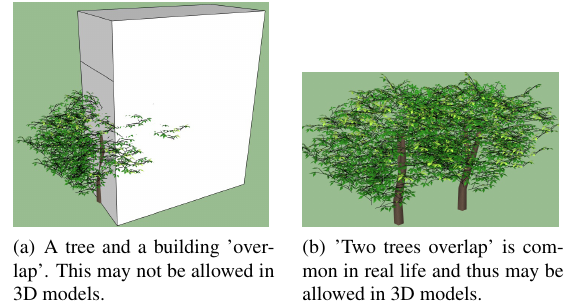
Figure 3: Objects with the same geometry but different semantics may be treated differently in 3D models.